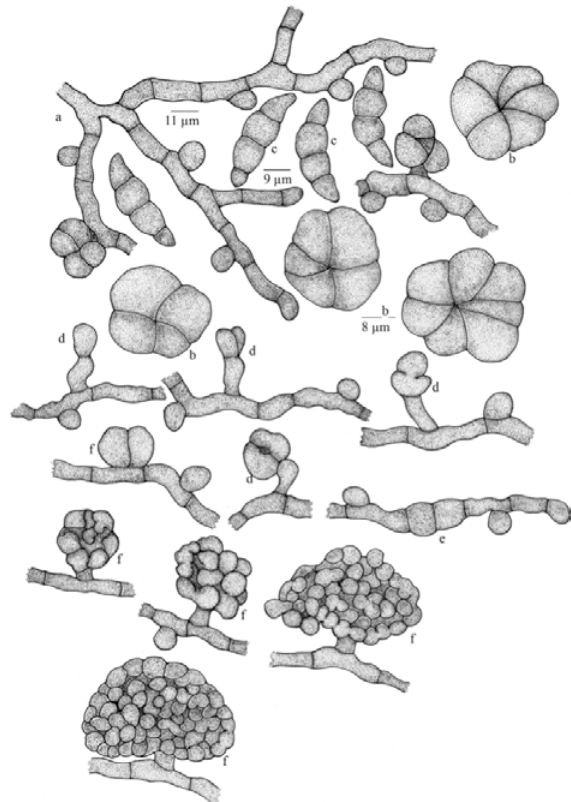
Figure 188. Sarcinella tamarindi a - Appressoriate mycelium; b - Sarcinella conidia; c - Questieriella conidia; d - Development of Sarcinella conidia; e - Germinating Questieriella conidia; f - Developing thyriothecium